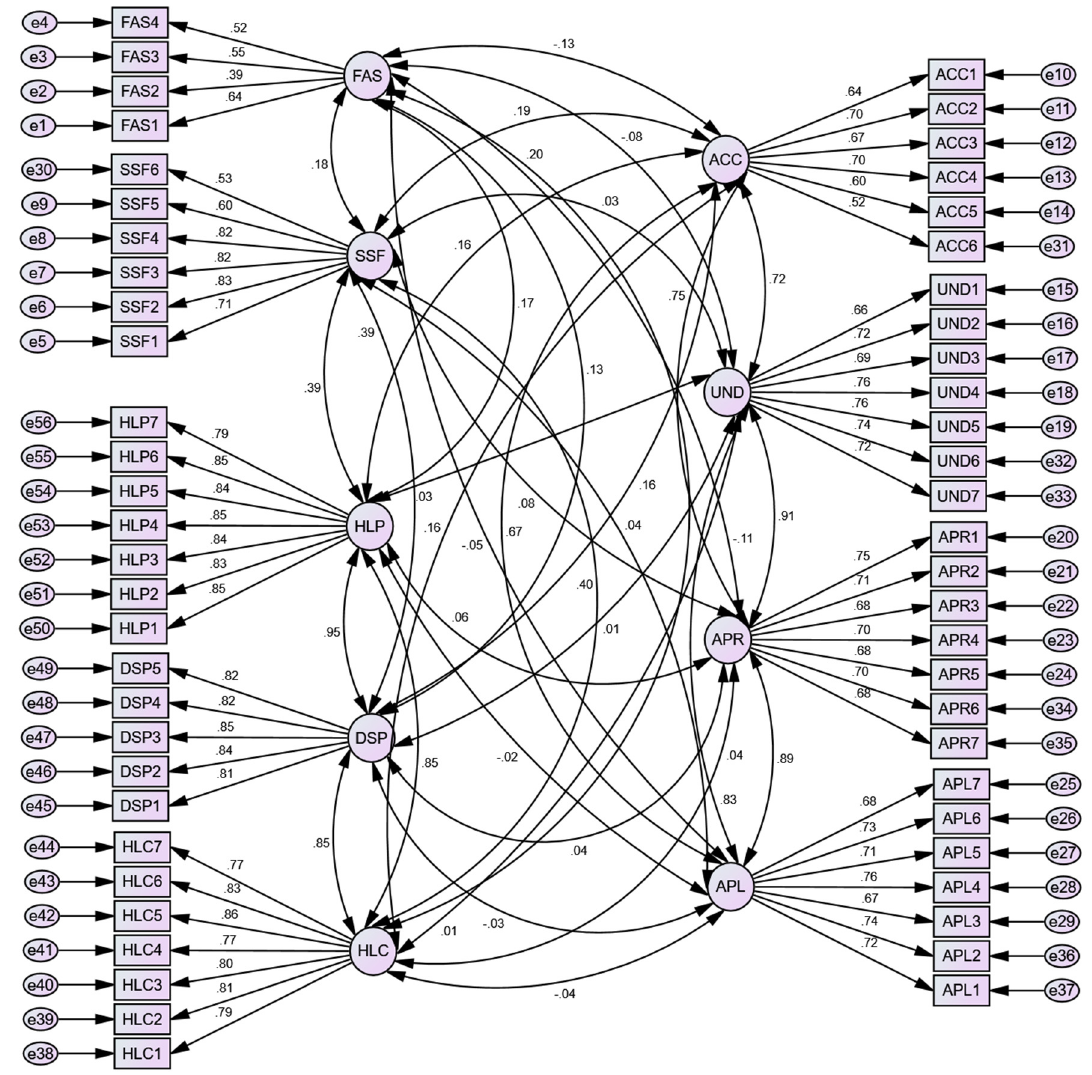
Figure 3. Confirmatory factor analysis (CFA) estimating the constructs. See Appendix B for detailed descriptions of family affluence status (FAS), social and family support (SSF), accessing (ACC), understanding (UND), appraising (APR), applying (APL), healthcare (HLC), disease prevention (DSP), and health promotion (HLP) items.